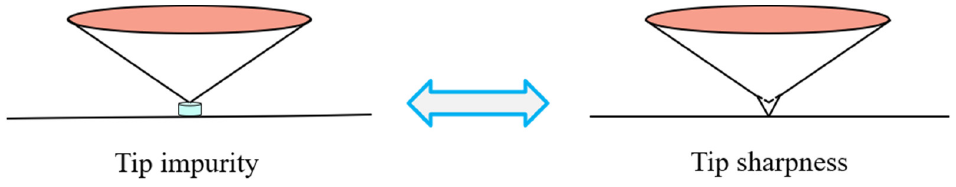
Figure 14. Schematic of the comparison between tip impurity and tip sharpness.